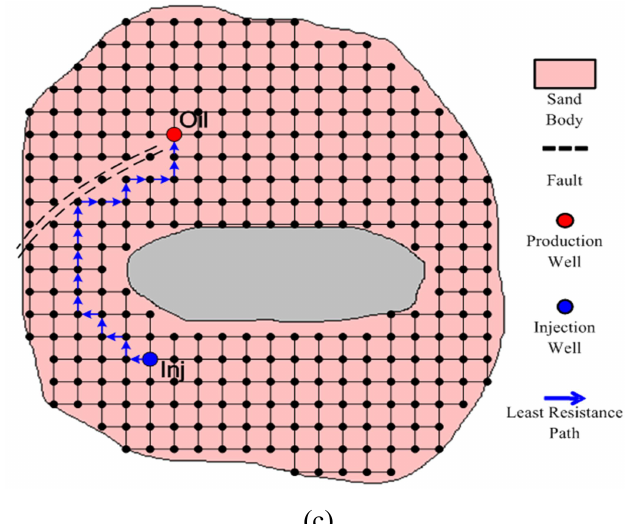
Figure 3—Construction of all the visible points. (a) The sand body where water injection well (Inj) and production well (Oi)l are located. (b) The unweighted visibility graph of the sand body. (c) The least resistance path between water injection well (Inj) and production well (Oil).